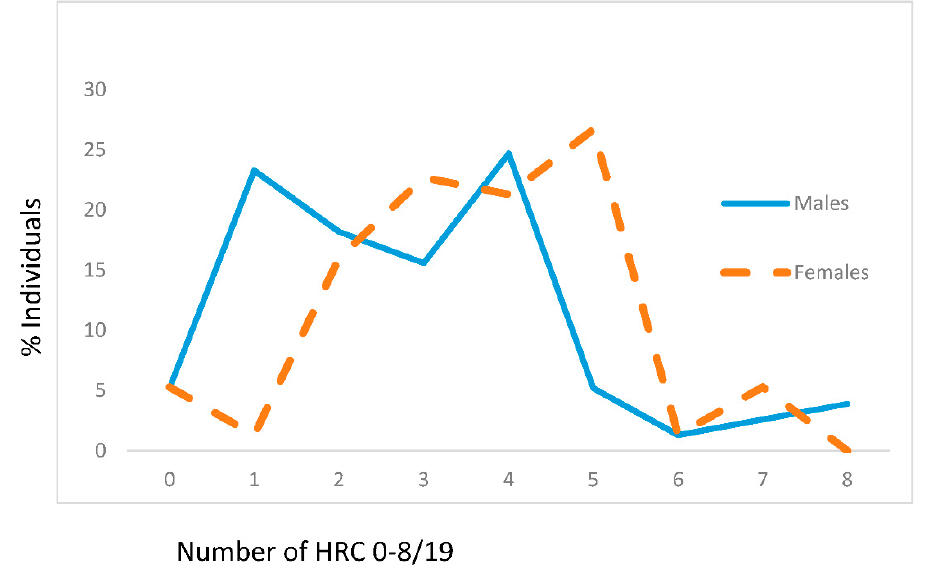
Figure 1. Frequencies of homozygous recessive characteristics (hrc) in males and females of the control group. X—mean values with standard deviation, V—variability, z—Mann Whitney U test. Males: n = 77, x hrc/19 = 2.88 ± 1.89 (95% CI 2.42–3.28). Females: n = 75, x hrc/19 = 3.65 ± 1.60 (95% CI 3.29–4.02; z = − 3.164, p = 0.002). V Males = 65.63%, V Females = 43.84%.